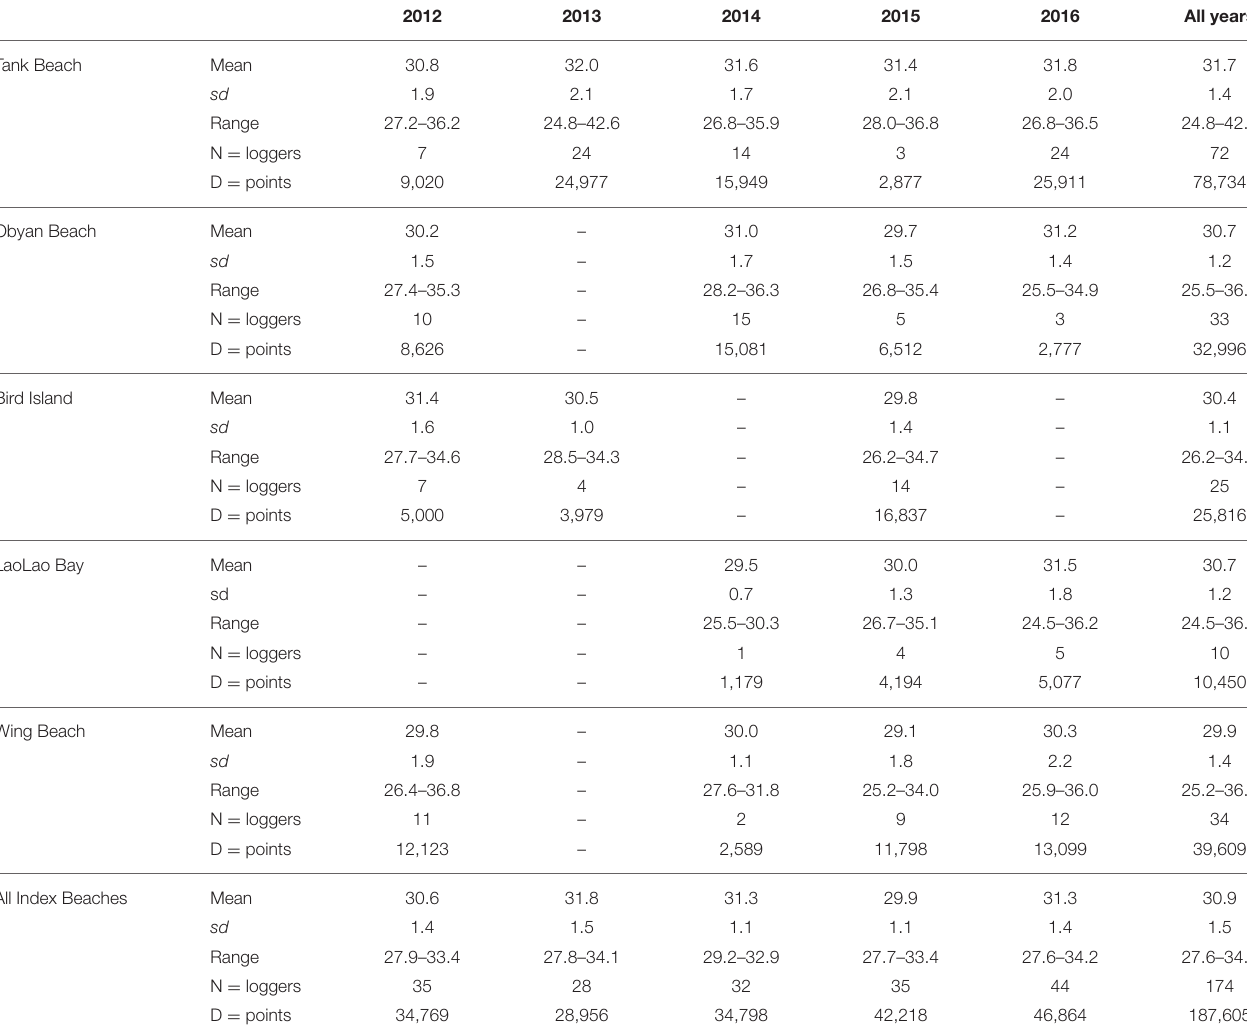
TABLE 3 | Temperature logger data ( ◦ C) from green turtle ( Chelonia mydas ) nests on Saipan index beaches, 2012–2016 ( n = 174